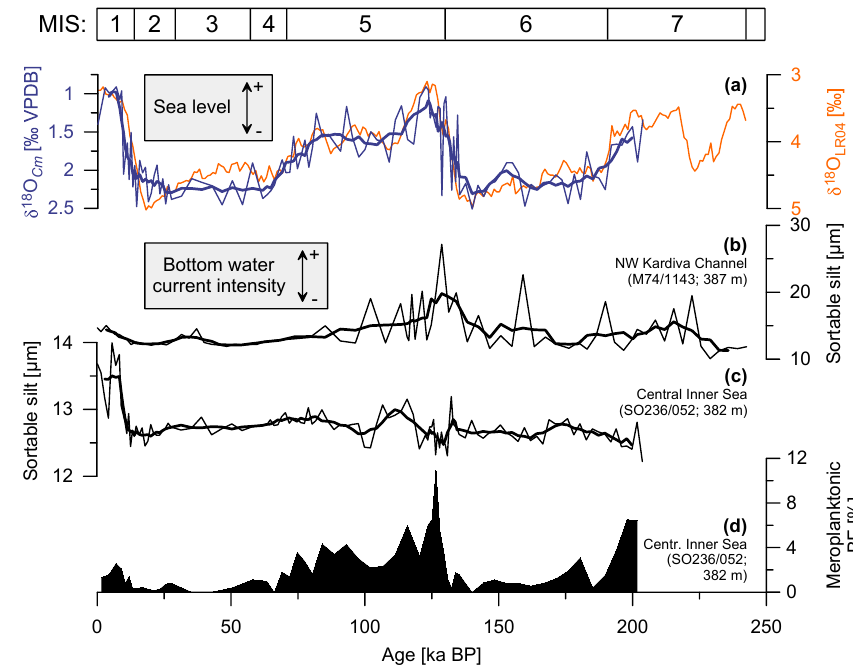
Figure 6. (a) Epibenthic stable oxygen isotope record of core SO236-052-4 (dark blue) in comparison with the LR04 benthic stable isotope stack (orange; Lisiecki and Raymo, 2005). (b, c) Comparison of the sortable silt records of sediment cores M74/4-1143 and SO236-052-4 and (d) relative abundance of meroplanktonic benthic foraminifera (BF; including the genera Cymbaloporetta and Tretomphaloides ) in sediments of core SO236-052-4. Thin lines represent full-resolution data, bold lines indicate 5-point running averages. MIS denotes the marine stable oxygen isotope stages.